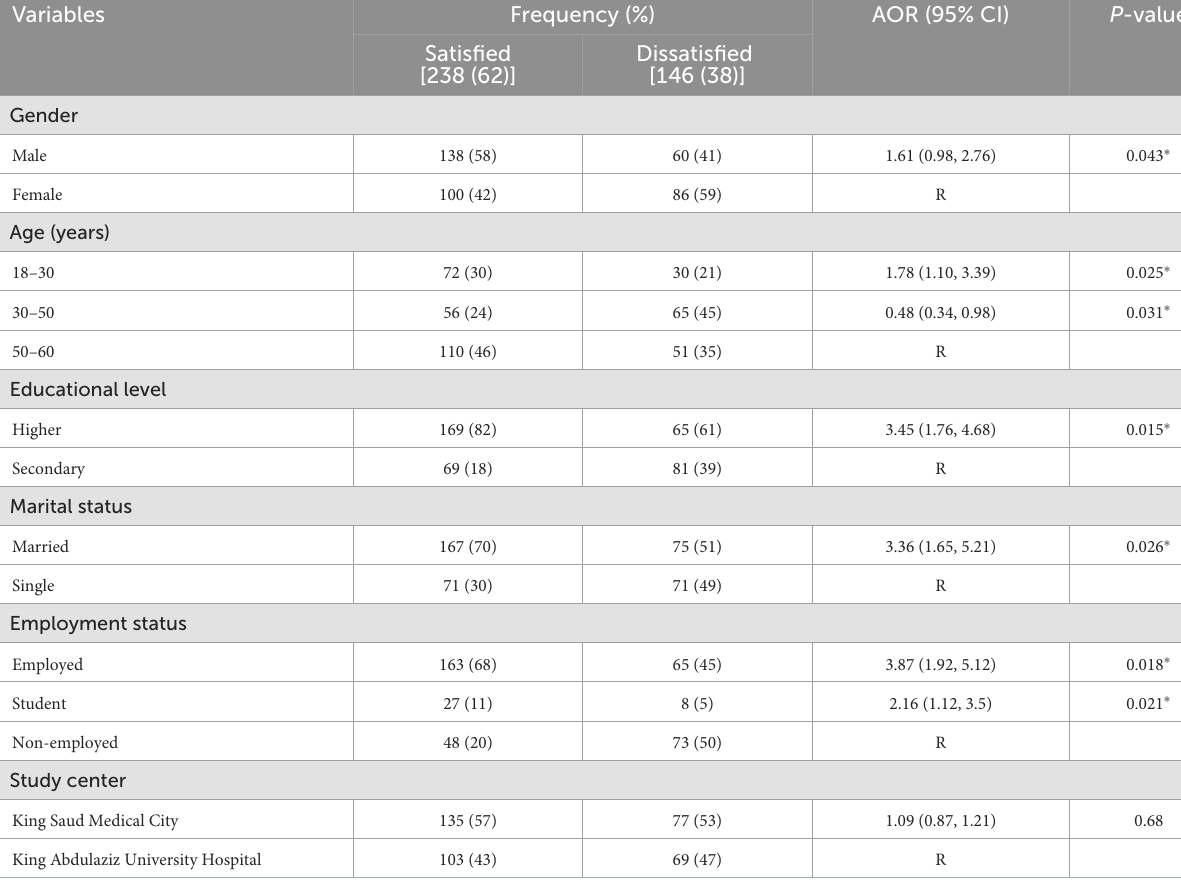
TABLE 3 Influence of factors on patients’ satisfaction using PSQ-18